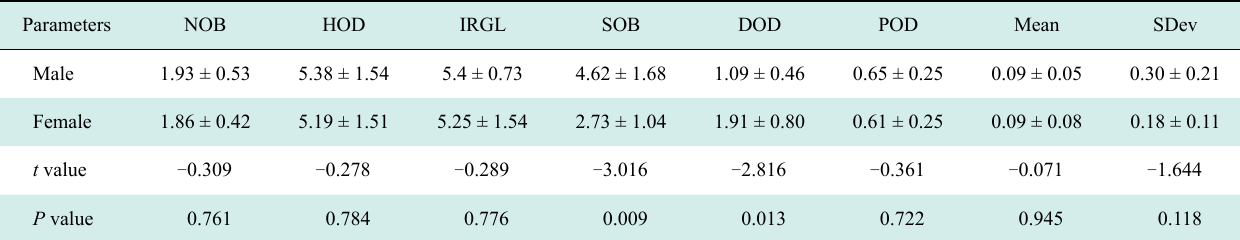
NOB, number of blobs of texture density; HOD, homogeneity of distribution of texture uniformity; IRGL, irregularity of texture primitive shape; SOB, mean size of blobs of texture primitive; DOD, directionality of texture distribution; POD, periodicity of texture distribution; Mean, Mean of texture gray scale; SDev, standard variance of gray scale. Table 5 Eight texture features of biceps brachii in healthy volunteers of different genders under contraction ( x ± s , n =30 samples) Parameters